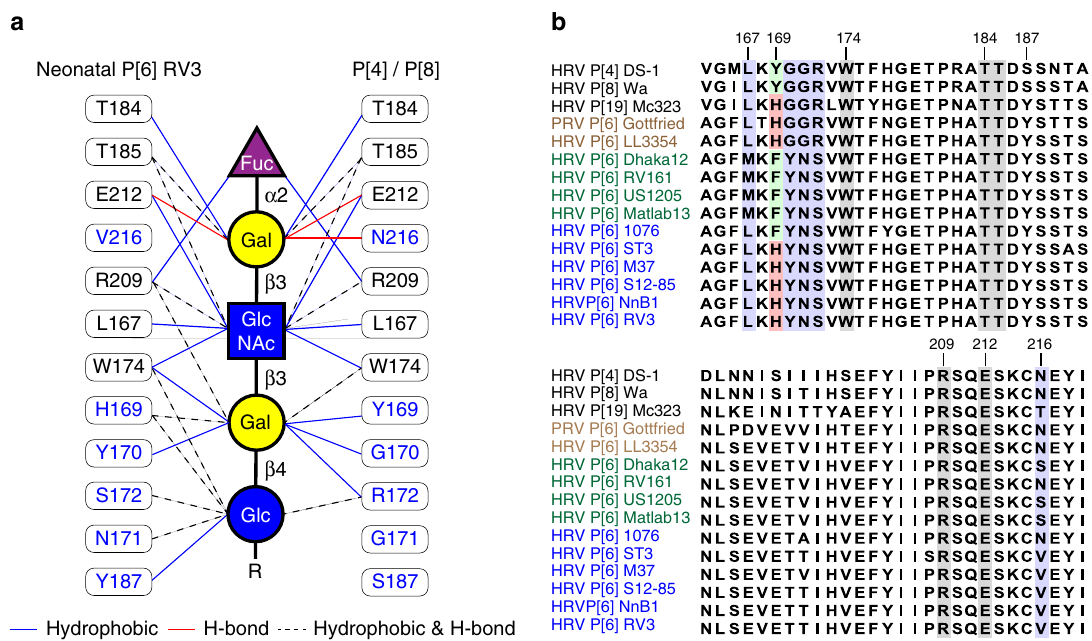
Fig. 7 Summary of mutations at the glycan binding site in the prevalent strains. a The schematic diagram of glycan recognition in VP8*s of P[6], P[4], P[8], and P[19] genotypes that belong to the P[II] genogroup shows the common residues (black) interact with the Fuc-Gal-GlcNAc moieties, and the sequence changes (blue) lead to distinct recognition of the reducing end of the glycan in VP8*s. The molecular interactions between H type I glycan and P[4]/ neonatal P[6] VP8*s are indicated by blue, red and black lines. The corresponding residues in P[6], P[8], and P[19] VP8*s are shown in the lateral columns. b Sequence alignment of VP8*s of the P[II] genogroup including those of porcine rotavirus (PRV) P[6], neonatal and non-neonatal P[6] HRV 16 . The conserved residues that recognize the type I precursor are indicated black shades, and other glycan binding residues are indicated by blue shade. The mutations at residue 169 are highlighted with green and red